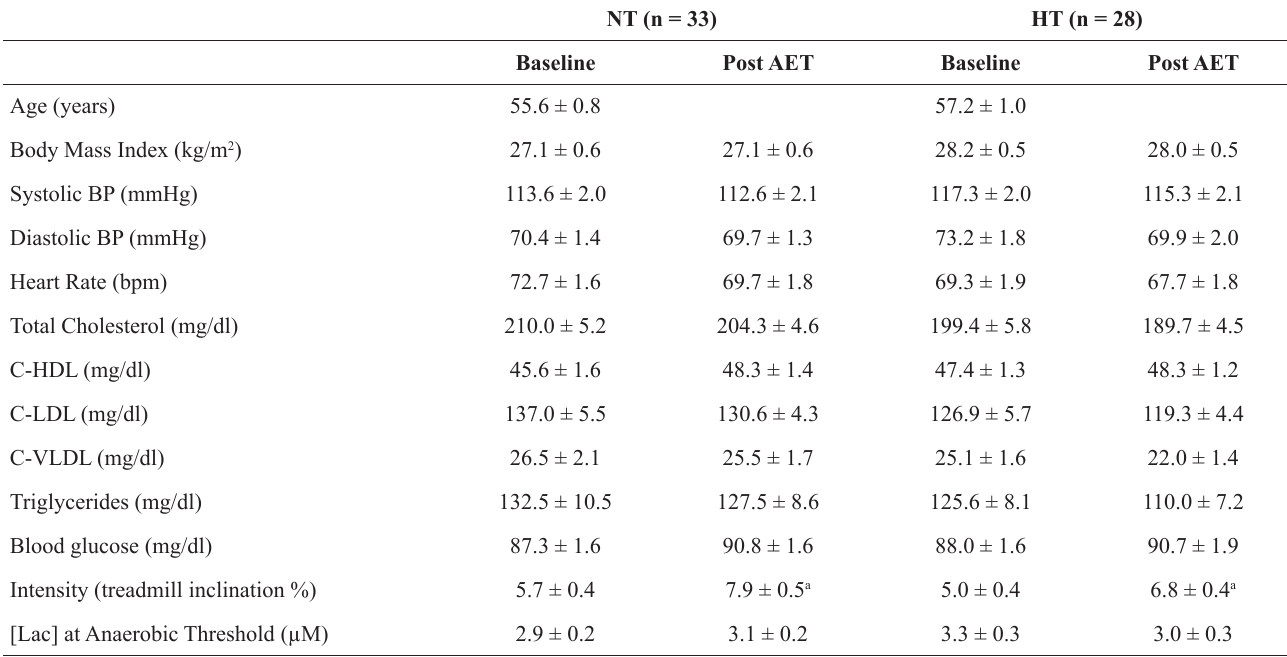
Table 1. Effects of aerobic exercise training on anthropometric, cardiovascular, biochemical parameters and aerobic capacity test in hypertensive postmenopausal women comparing with